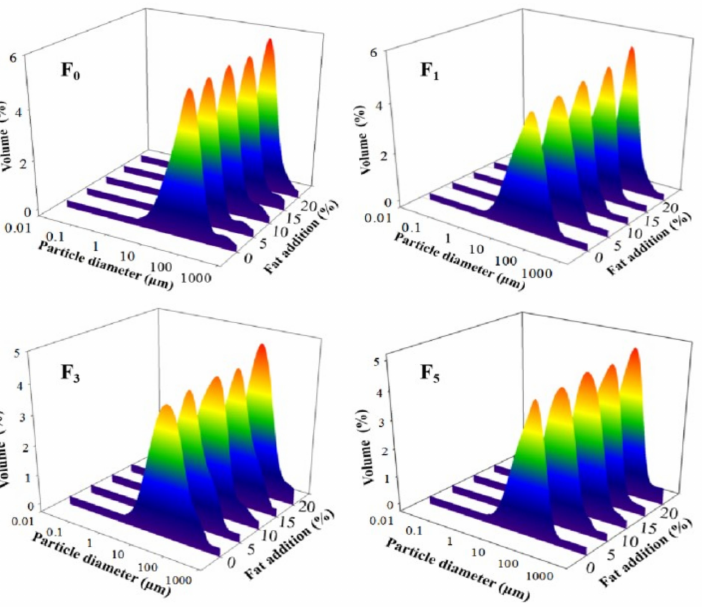
Figure 2. Influence of F–T cycles on volume-based particle size distribution of myofibrillar protein from quick-frozen patties with different fat levels. F 0 , F 1 , F 3 and F 5 means different F–T